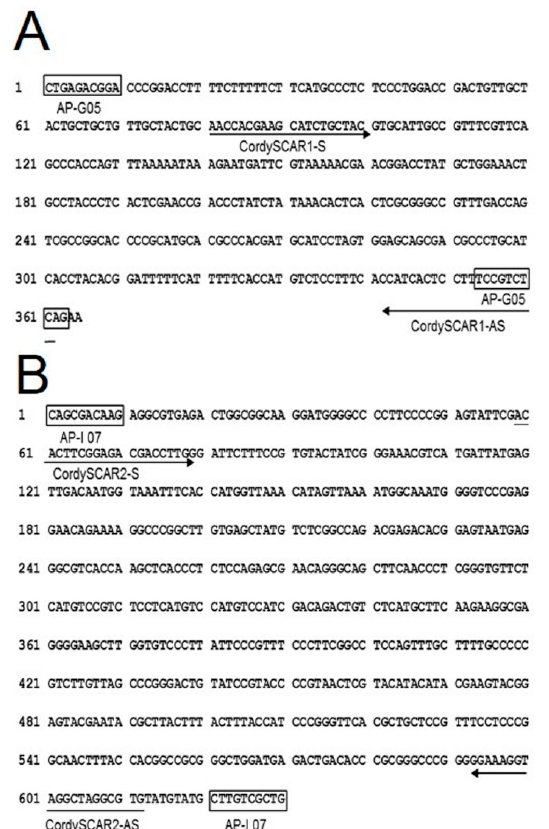
Figure 3. Profiles of Cordyceps species amplified with RAPD primers. ( A ) AP-G 05 and ( B ) AP-I 07 were used for PCR, and the products were subjected to 1.2% agarose gel. Lane M: 1-kb DNA ladder; Lane B: blank (nuclease-free distilled water); Lanes 1–12: C. sinensis ; Lane 13: C. gracilis ; Lanes 14–15: C. hawkesii ; Lane 16: C. gunnii . Independent experiments were repeated three times, n = 3.